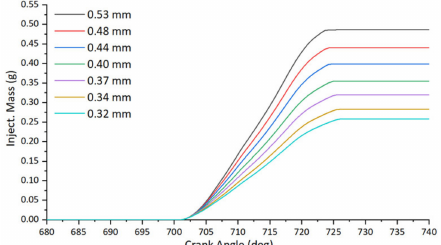
Figure 20. Cumulative fuel injection mass per cycle under varied nozzle diameters.